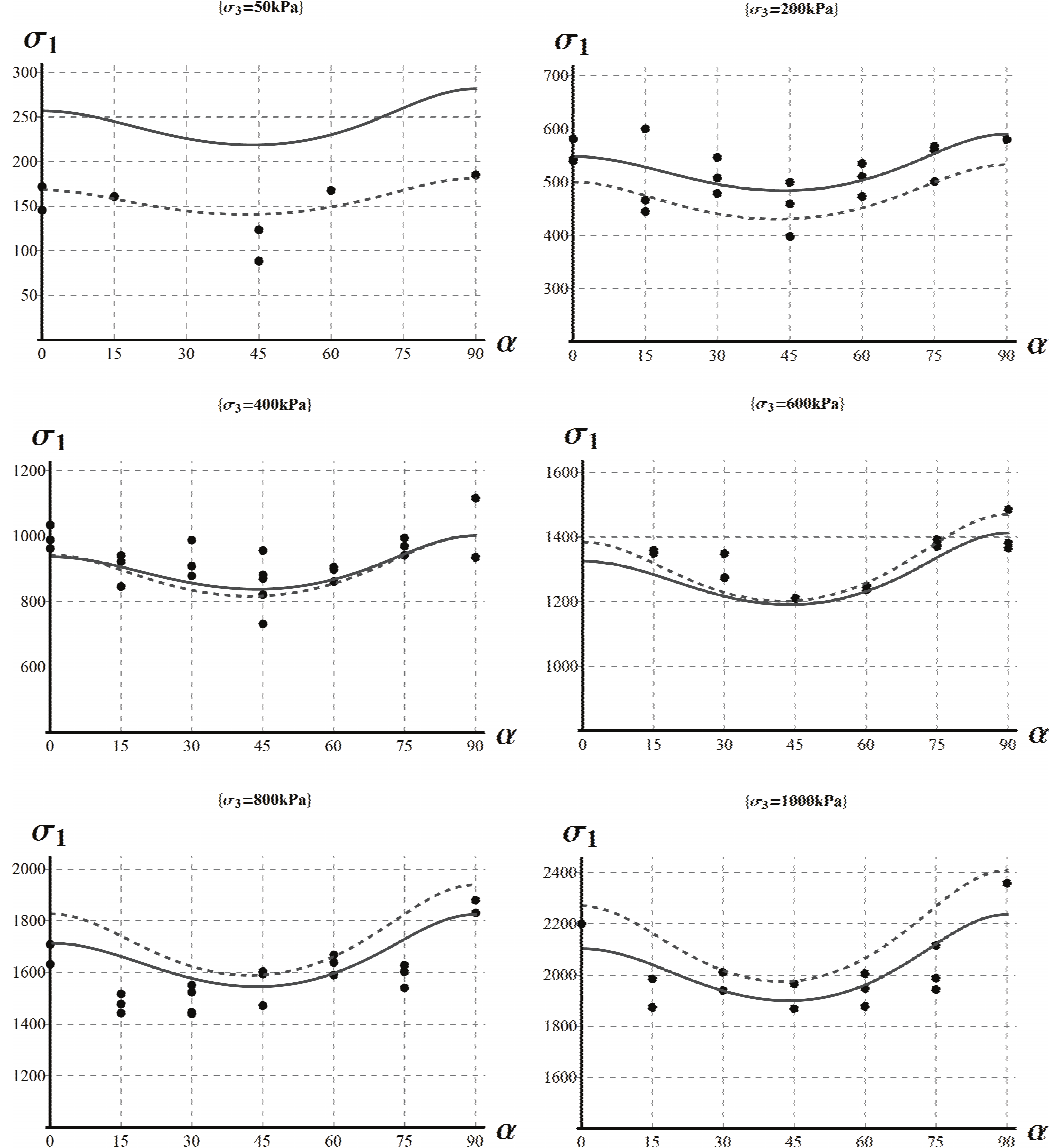
Fig. 3. Comparison of the Pariseau criterion with the experimental data.